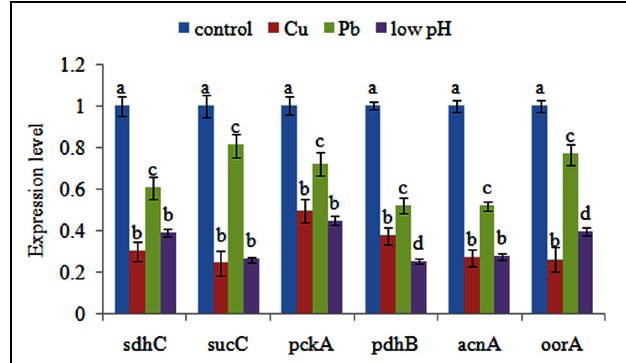
FIGURE 1 | Quantitative real-time PCR (qPCR) analysis of the expression of sdhC , sucC , pckA , pdhB , acnA , and oorA after stress treatments in comparison to untreated control. The data are presented as the means ± SD, n = 6. The means of the treatments not sharing a common letter are significantly different at P <